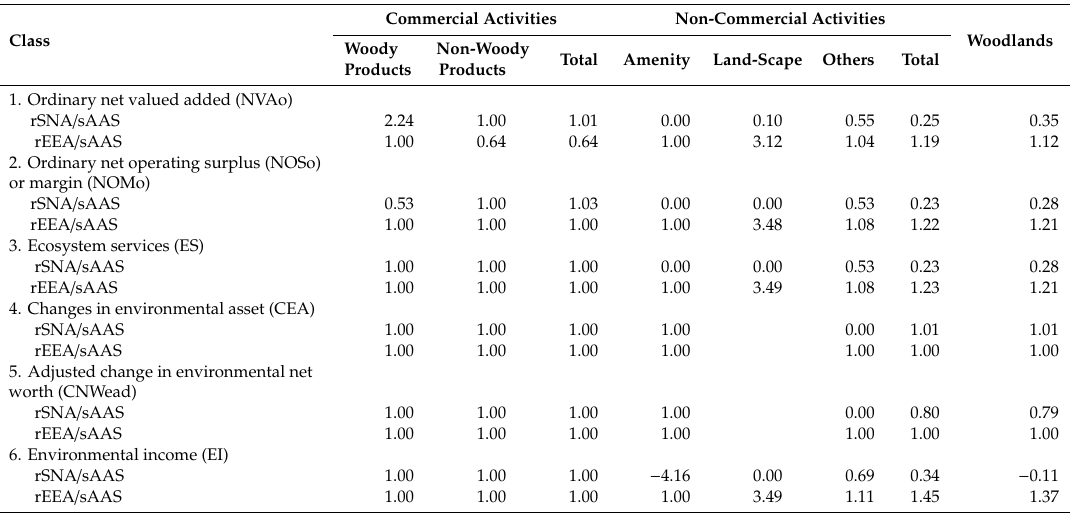
rSNA and rEEA versus sAAS commercial and non-commercial